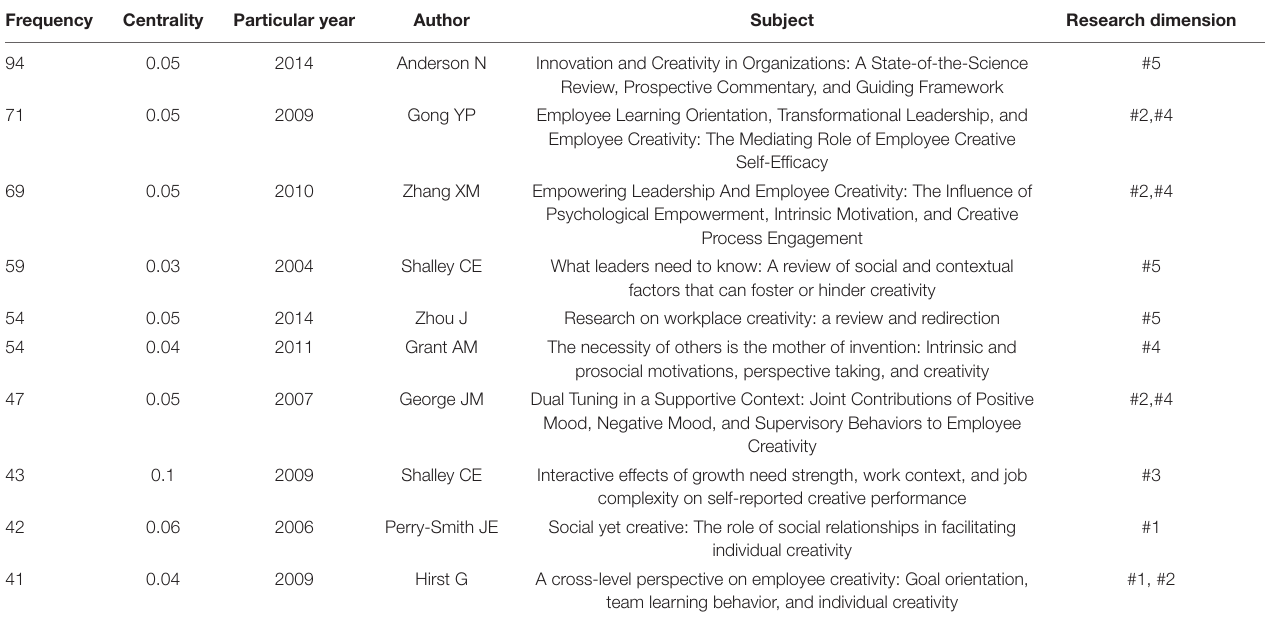
TABLE 2 | Basic literature based on co-citation (Citation Frequency top 10).